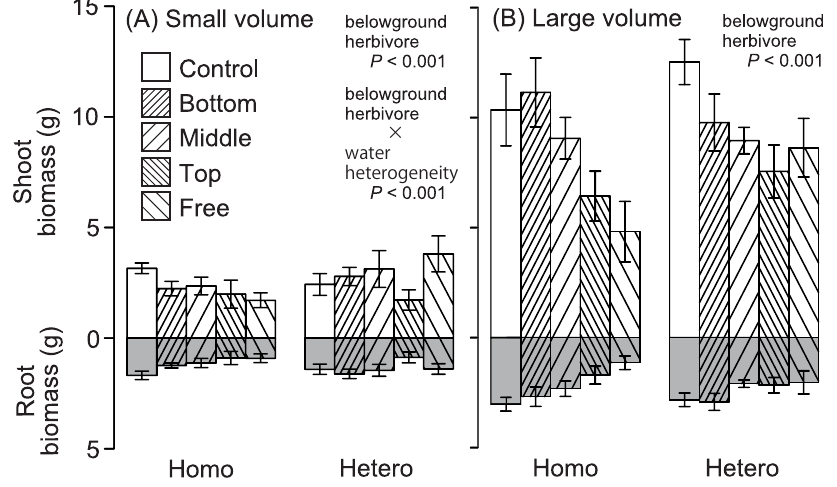
Figure 2. Mean of the shoot and root biomass ( 6 SE). (A) Small water volume. (B) Large water volume. Control, no herbivore present; Bottom, Middle, Top; herbivores placed in the bottom, middle, and top zones, respectively, of the pot; Free, herbivore present and free to move in all zones of the pot. Homo, homogeneous water supply; Hetero, heterogeneous water supply. Biomass in the top treatment was the smallest between the middle, bottom, and control treatments in every watering treatment. Biomass in the free treatment was similar to that in the top treatment in every watering treatment, except for the heterogeneously-applied treatment with small volume of water. doi:10.1371/journal.pone.0100437.g002 Roots of the survived plants reached the bottom zone at the harvest.